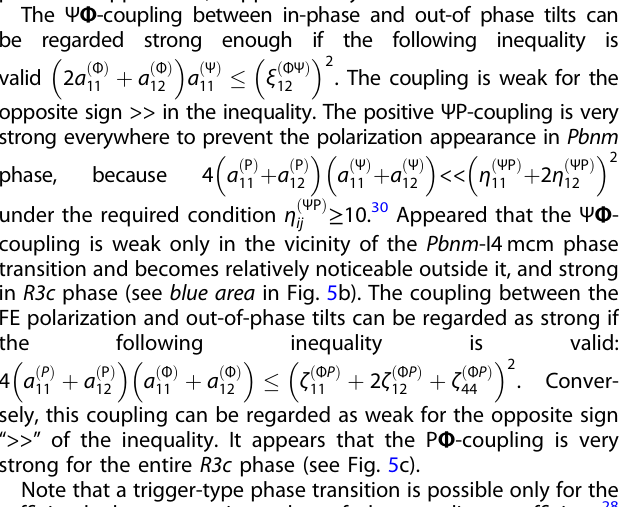
Fig. 5 a Temperature dependence of different phases ’ energies, whose symbols (observable R3c , Pbnm , 4/mcm , and non-observable Imbm ) are speci fi ed near the curves. The predicted Imbm phase is shown by fi lled rectangle that has about 17 K width. Fitting parameters are listed in Table 2. b The red solid curve is 26 the biquadratic coupling coef fi cient squire ξ Φ ψ ð Þ